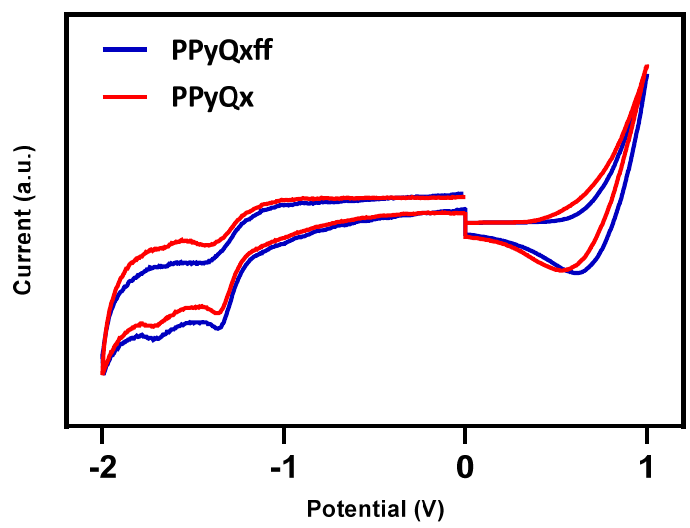
Figure 3. Cyclic voltammetry curves of PPyQxff and PPyQx.